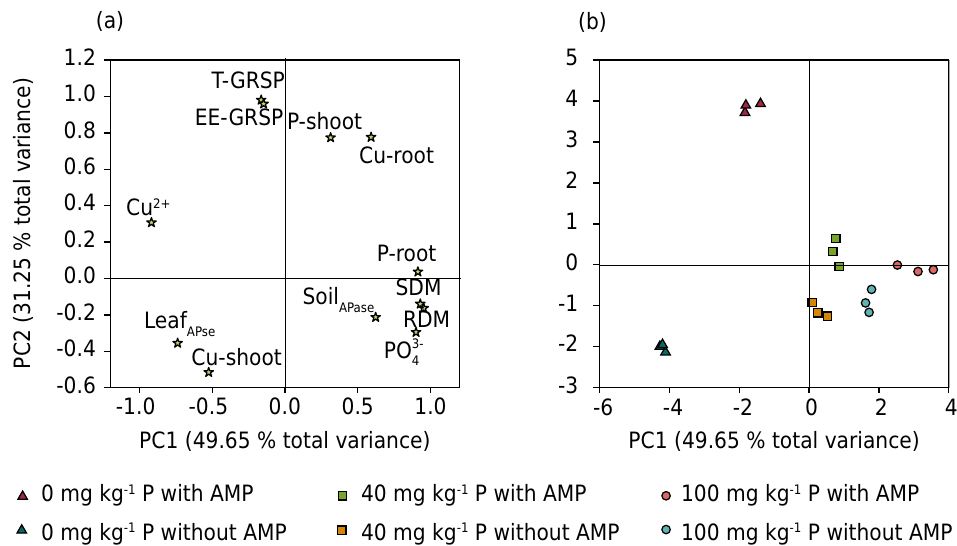
Figure 6. Factorial analysis of the (a) studied variables, and (b) distribution of experimental units according the principal components (PC) obtained, for plants and rhizosphere of Crotalaria juncea growing in a soil with high Cu levels. The PC1 and PC2 account for a 79.8 % of the total experimental variance. Conventions: shoot dry matter (SDM), root dry matter (RDM), GRSP T (total glomalin-related soil protein), and GRSP EE (easily extractable glomalin-related soil protein) for Crotalaria juncea grown in a soil with high copper (60 mg kg -1 ) levels under different levels of phosphorus with and without AMF